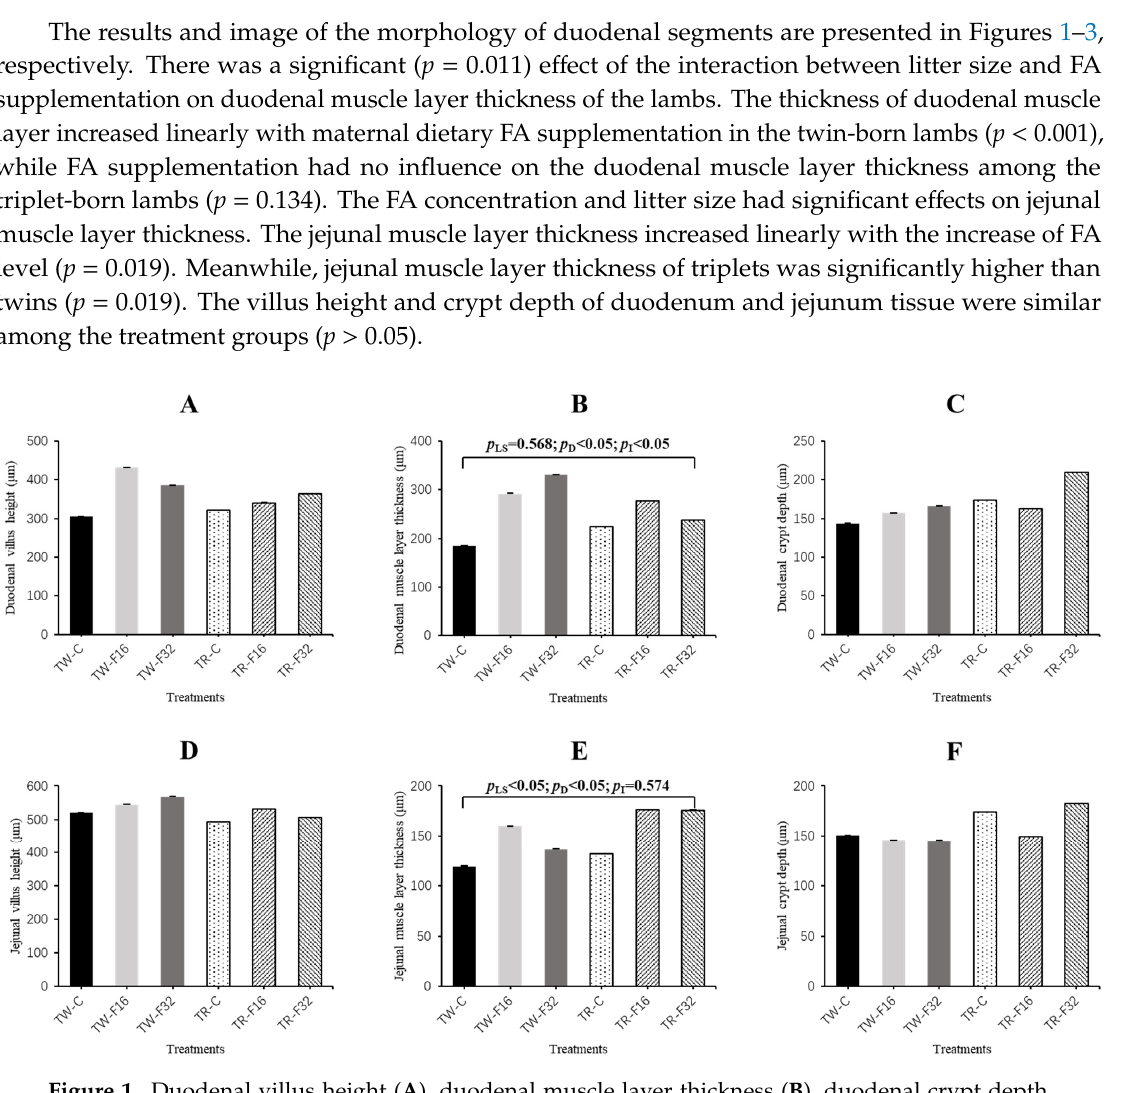
Table 3. Effect of dietary folic acid supplementation during gestation on intestinal index of newborn lambs.